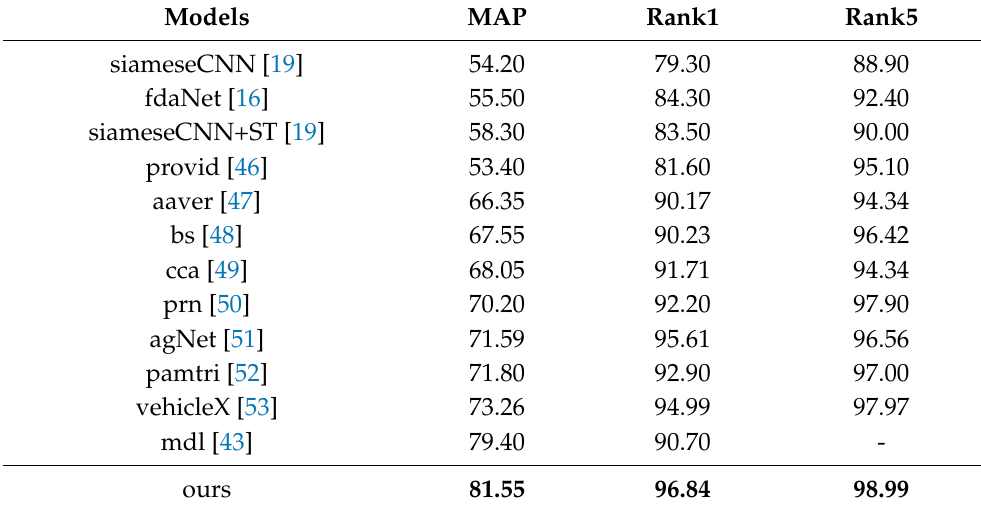
Table 3. Test on VeRi